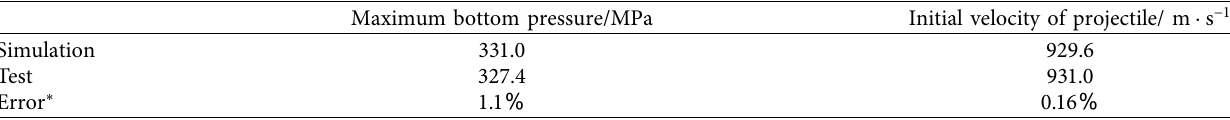
Table 1: The calibration data of the test device.